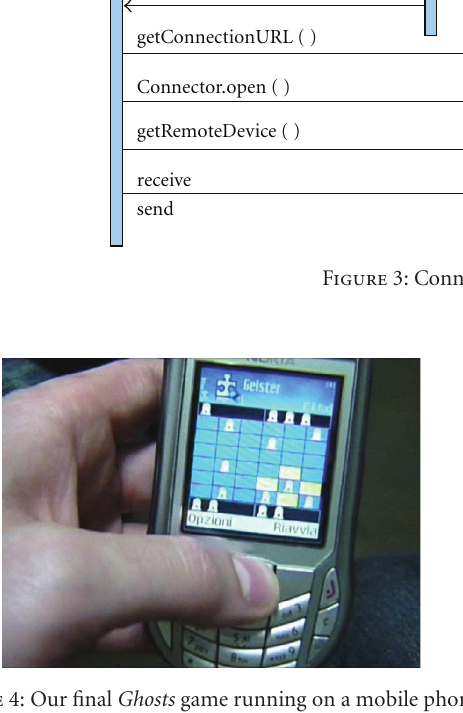
Figure 4: Our final Ghosts game running on a mobile